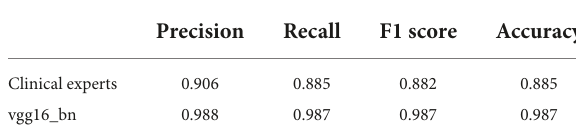
TABLE 2 Confusion matrix comparison of AI vs. clinical